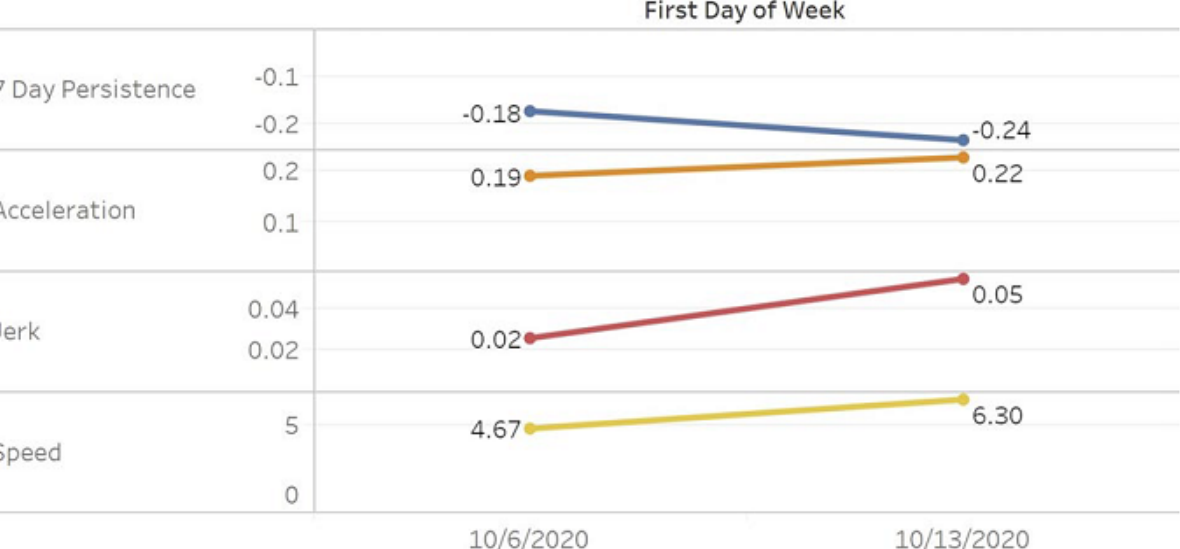
Figure 2. Weekly SARS-CoV2 trends in Central Asia